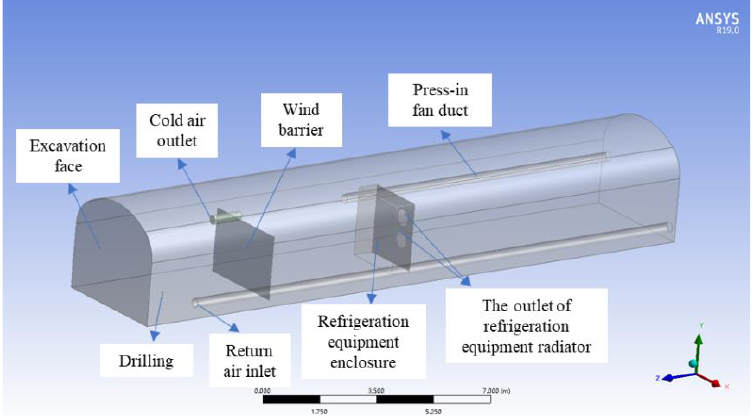
Figure 7. Geometric